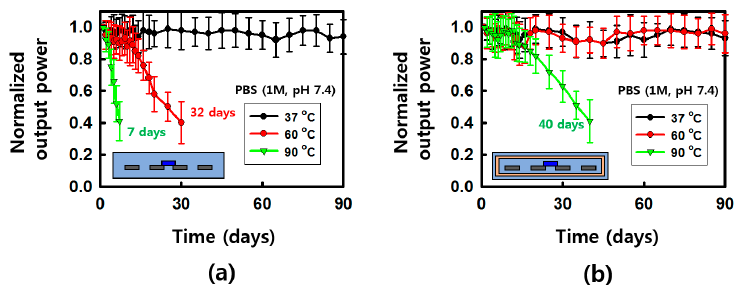
Figure 4. Barrier properties of a protection layer-coated optoelectronic device. ( a ) Normalized output power of PDMS-coated devices as a function of immersion time in phosphate bu ff er solution (PBS) (1 M, pH 7.4) with di ff erent temperatures; ( b ) normalized output power of PDMS / Parylene C / PDMS-coated devices as a function of immersion time in phosphate bu ff er solution (PBS) (1 M, pH 7.4) with di ff erent temperatures.